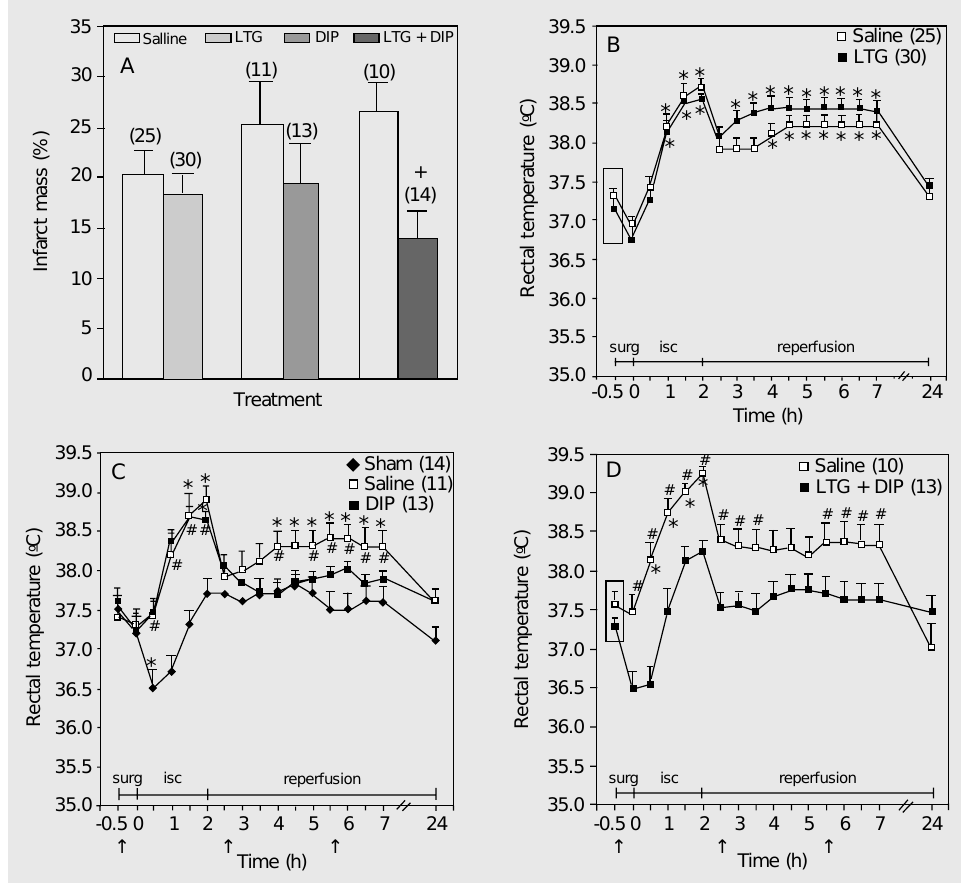
Figure 3. Effect of lamotrigine (LTG) alone or in combination with dipyrone (DIP) on ischemia- induced brain damage and hy- perthermia. Data are the means ± SEM and the number of ani- mals studied in each group is given in parentheses.